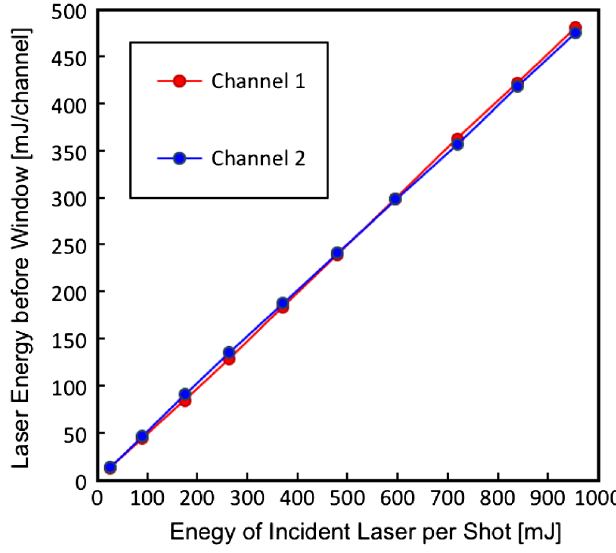
FIG. 27. Laser energy on each beam channel at entrance of the ion source chamber.